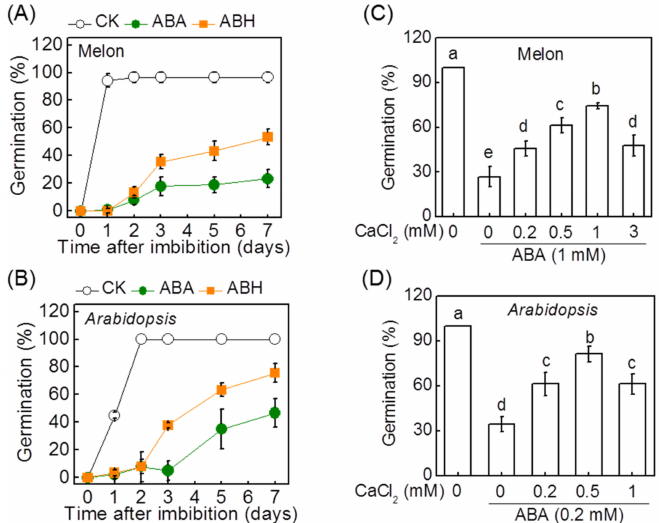
Figure 1. H 2 O 2 and Ca 2+ counteract abscisic acid (ABA) to promote seed germination in melon and Arabidopsis . ( A , B ) The effects of ABA and the combination of ABA and H 2 O 2 (ABH) on the germination of melon and Arabidopsis seeds. ( C , D ) The effects of ABA and the combination of ABA and CaCl 2 (ACa) on the germination of melon and Arabidopsis seeds. The melon seeds were presoaked in double-distilled water or test solutions for 7 h and then were incubated at 30 ◦ C for 7 days. In ( C , D ), the germination rates were recorded on the seventh day after seed incubation. Data are means ± SD (3 replicates × 30 seeds). The different letters denote a significant difference ( p < 0.05) according to Tukey’s